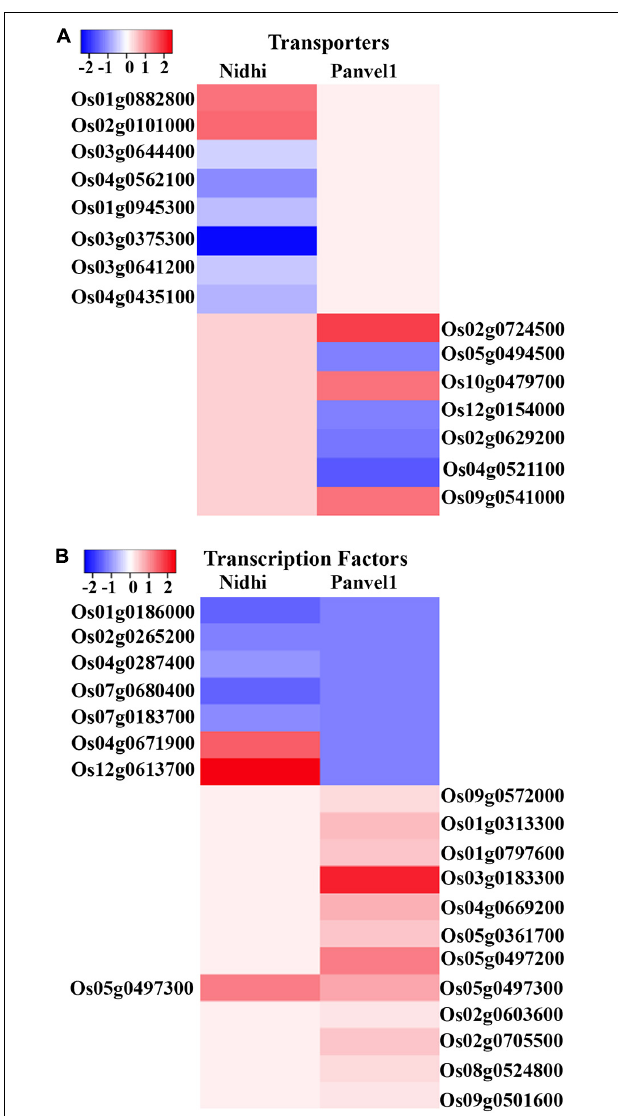
FIGURE 4 | (A) Heat map was constructed using Heatmapper, which represents the expression pattern of nitrate regulated differentially expressed genes (DEGs) of the top two transporters’ families for Nidhi and Panvel1 rice contrasting genotypes. For Nidhi, the top two transporter families are Amino Acid/Auxin Permease (AAAP) Family and Amino Acid-Polyamine-Organocation (APC) Family, while for Panvel1 they are Drug/Metabolite Transporter (DMT) Superfamily and Major Intrinsic Protein (MIP) Family. (B) Expression pattern of nitrate regulated DEGs of top two transcription factors’ families for Nidhi and Panvel1 rice contrasting genotypes. For Nidhi, the top two TFs families are WRKY and ARF, while for Panvel1 they are AP2 and